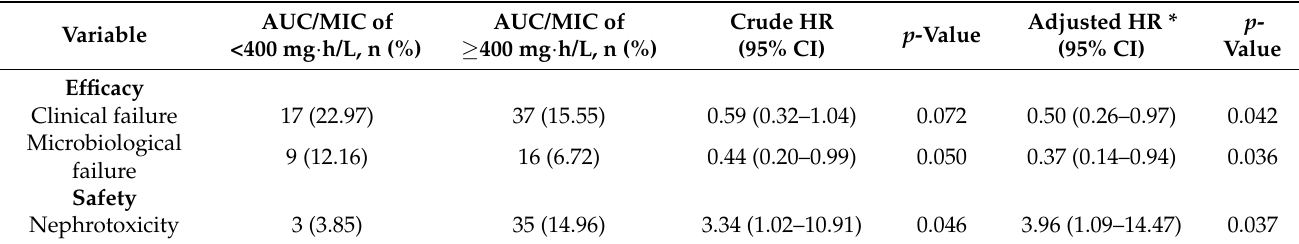
Table 3. Cox regression analysis of outcomes for enterococcal infection patients with vancomycin AUC/MIC of ≥ 400 mg ·